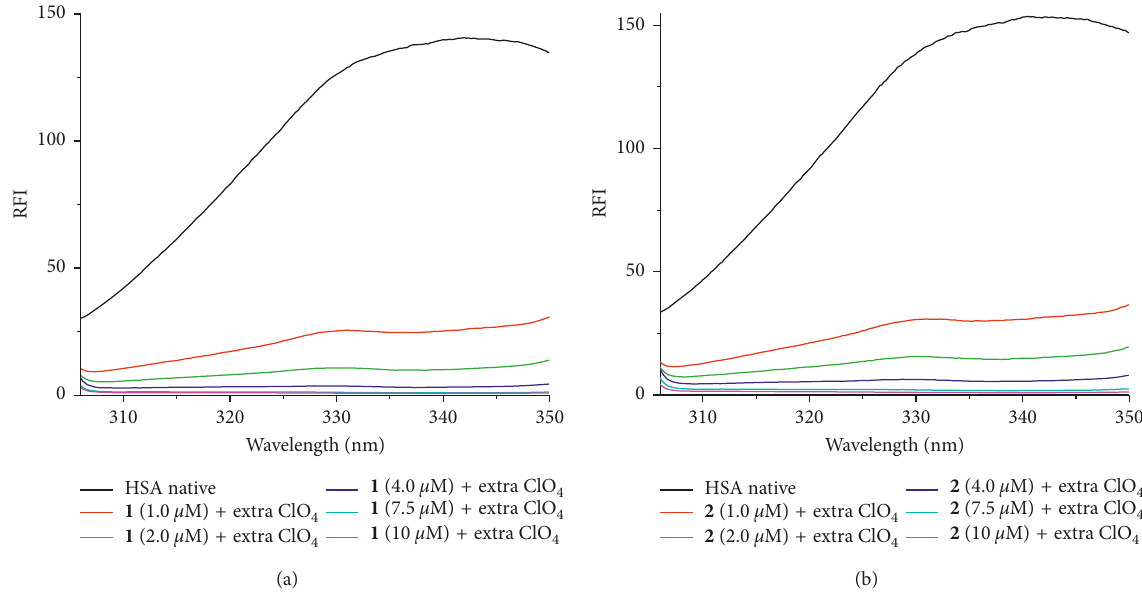
2 ]ClO 4 compound